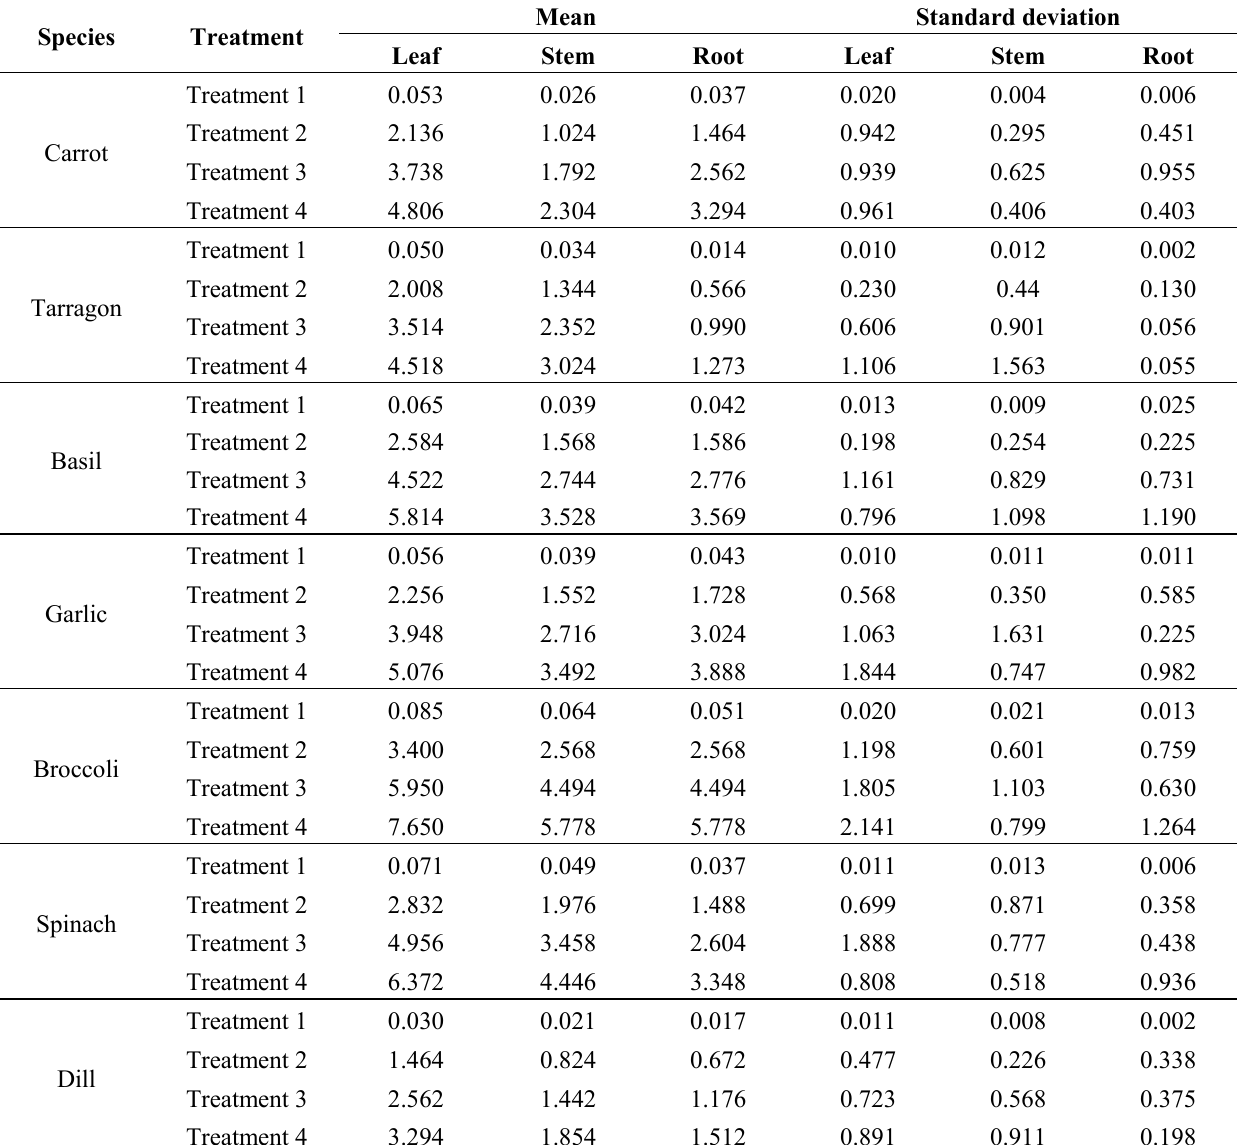
Table 8. Comparison of Cd concentrations (mg/kg) within different plant parts as a response to various cadmium (Cd) treatments (Table 3). Sample number n =